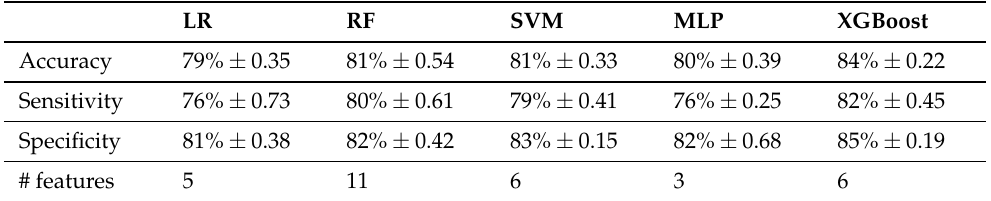
Table 2. Quantitative evaluation of the first stage of our system when filter-based method is the feature selection scheme. The values are average accuracy ± standard deviation.